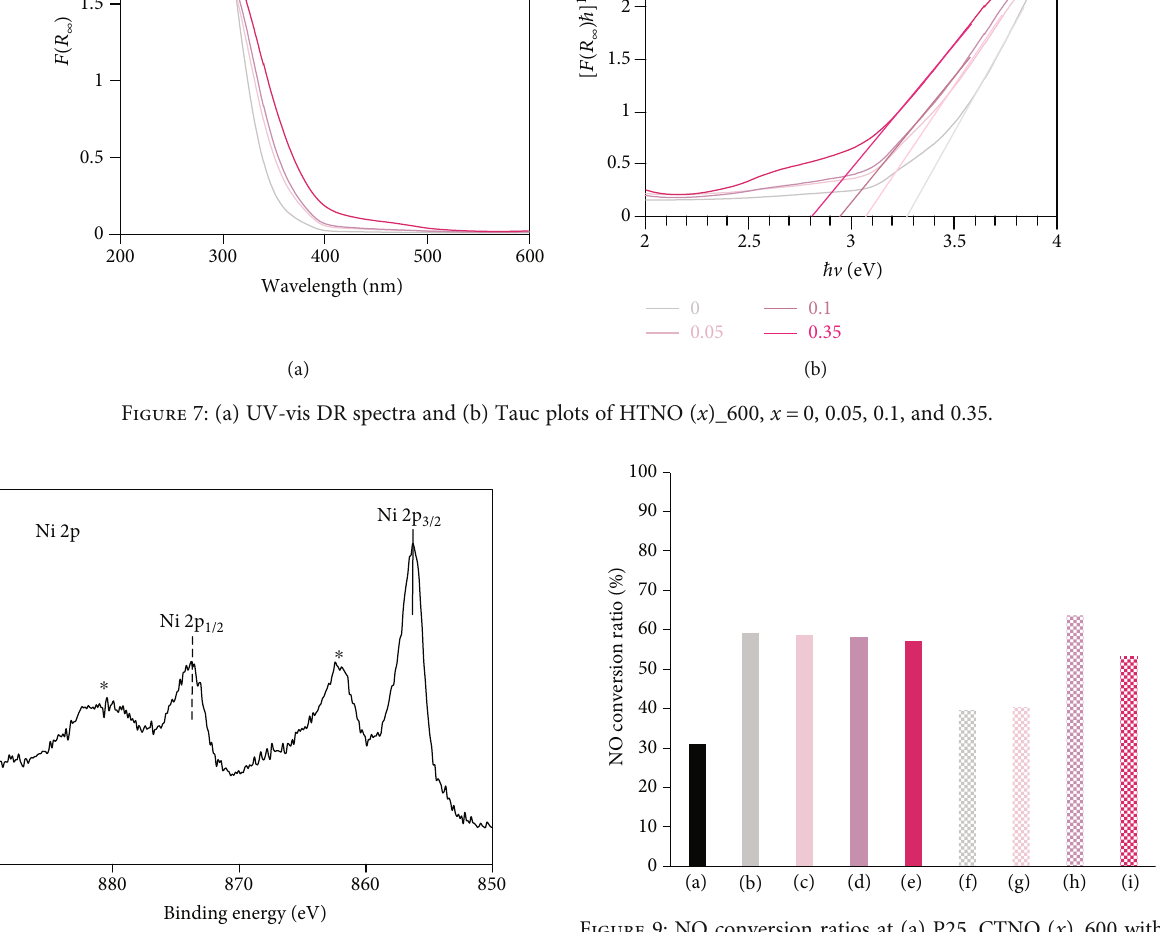
Figure 9: NO conversion ratios at (a) P25, CTNO ( x )_600 with x values of (b) 0, (c) 0.05, (d) 0.1, and (e) 0.35, and HTNO ( x )_600 with x values of (f) 0, (g) 0.05, (h) 0.1, and (i)